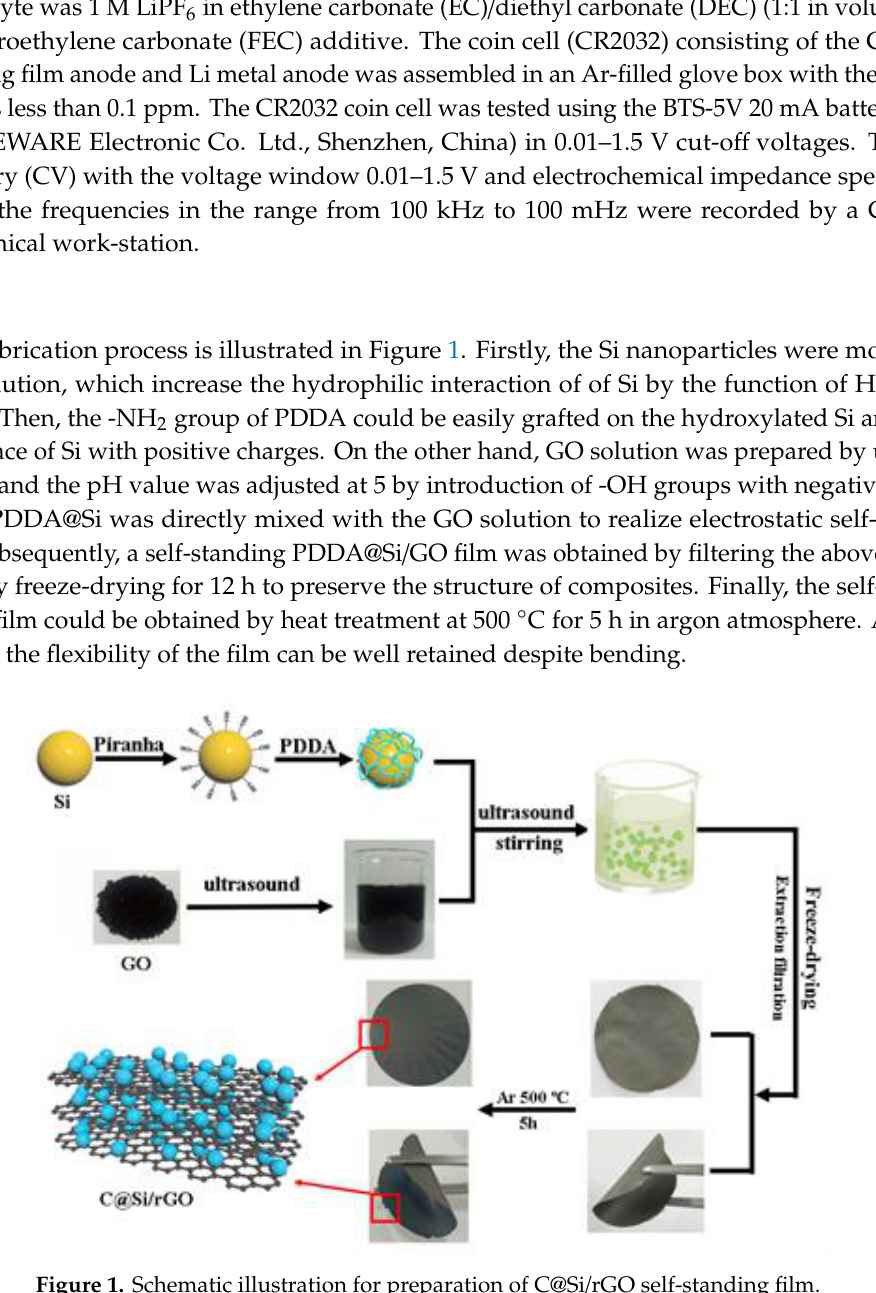
Figure 1. Schematic illustration for preparation of C@Si / rGO self-standing film.